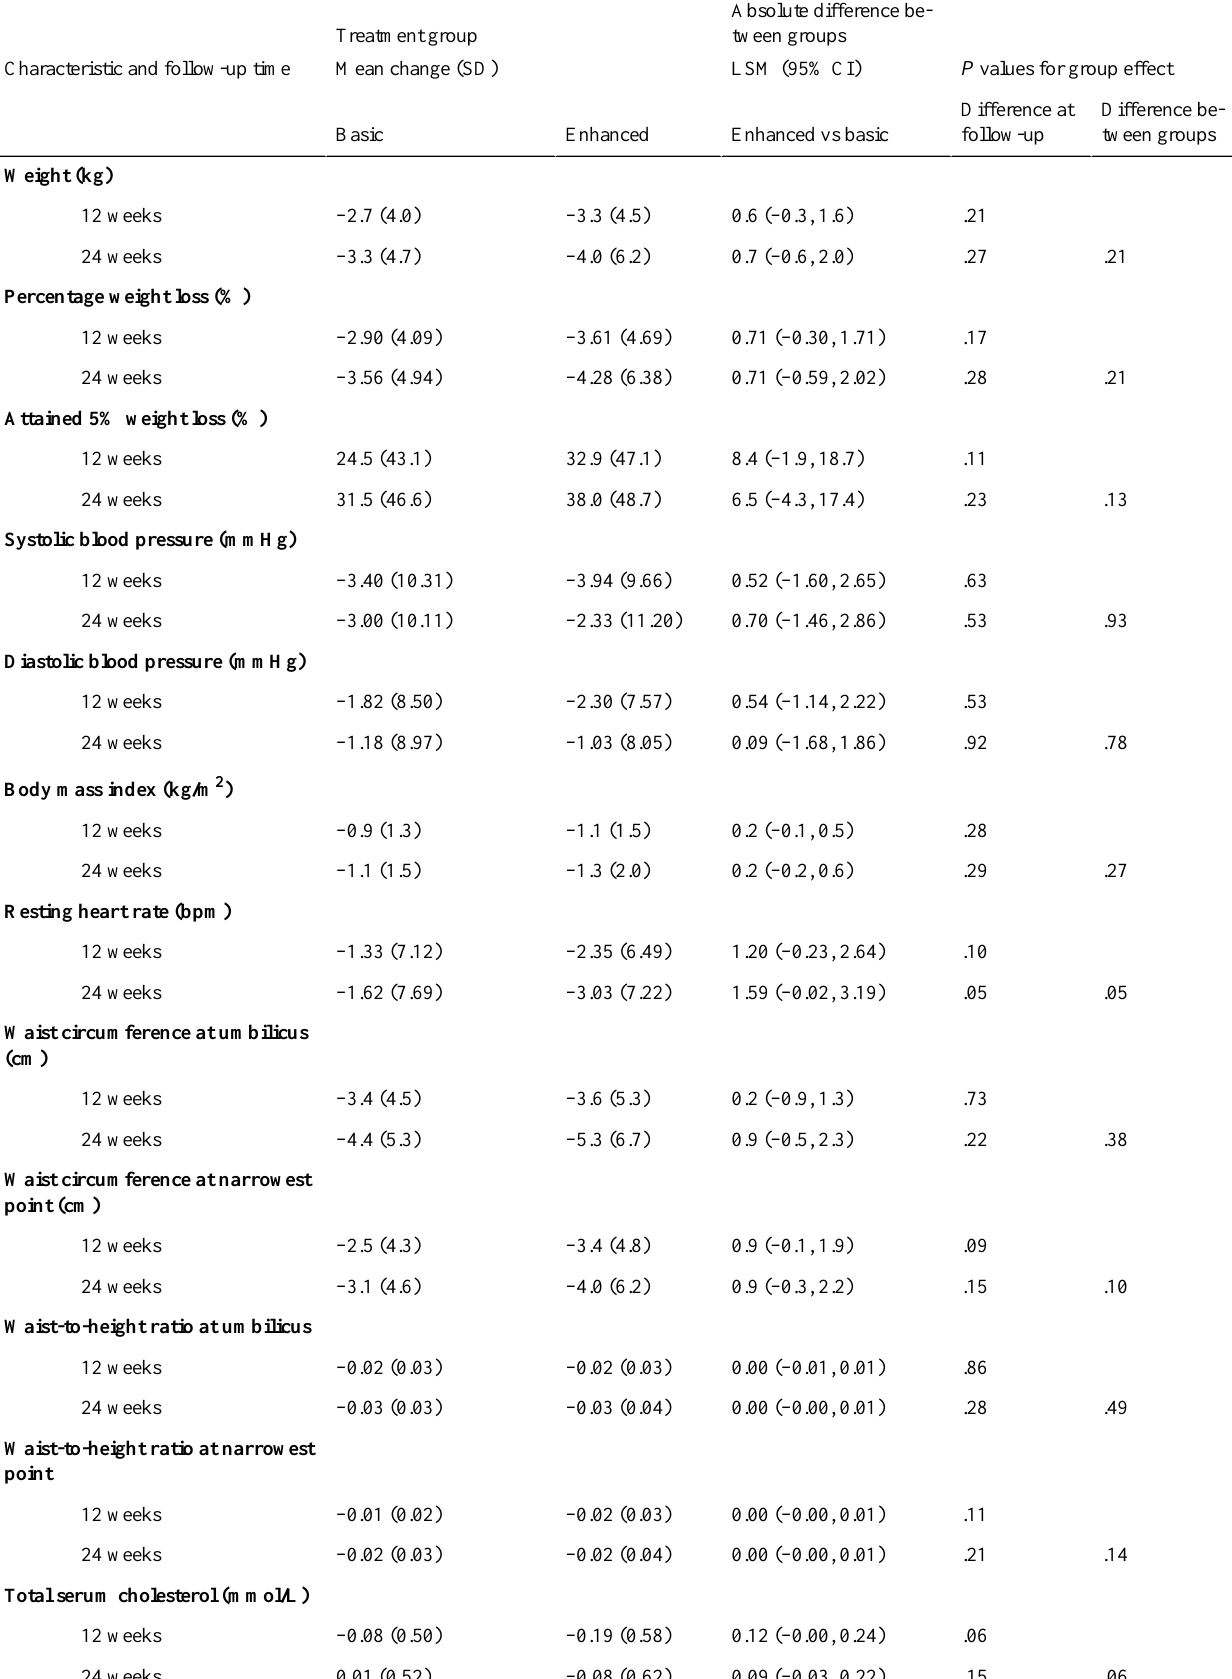
Table 3. Mean change in a range of variables from baseline to 12 weeks and baseline to 24 weeks within each treatment group and the least squares mean (LSM) difference in change between treatment groups (ITT population LOCF